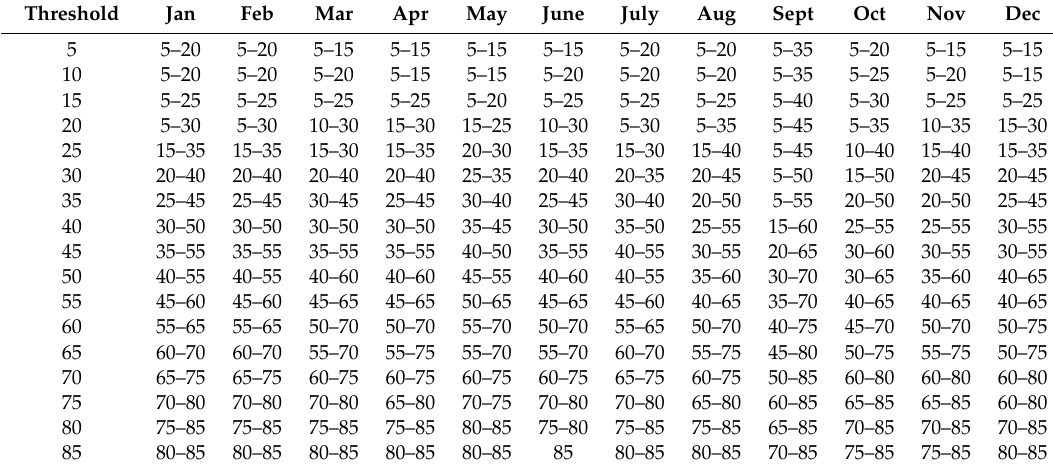
Table A1. Results of the Kolmogorov–Smirnov tests, where entries are the threshold values where no significant di ff erence was found between distributions.